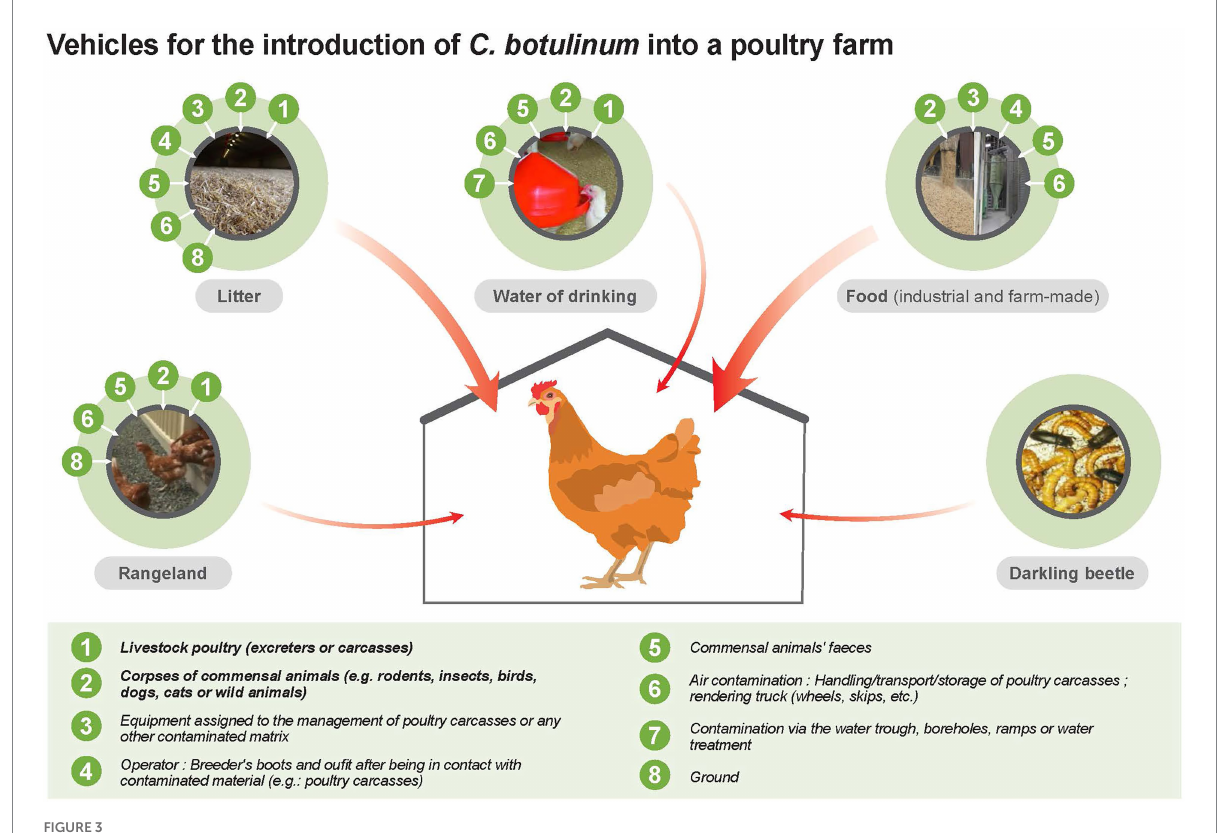
FIGURE 3 Epidemiological cycle of Clostridium botulinum in poultry